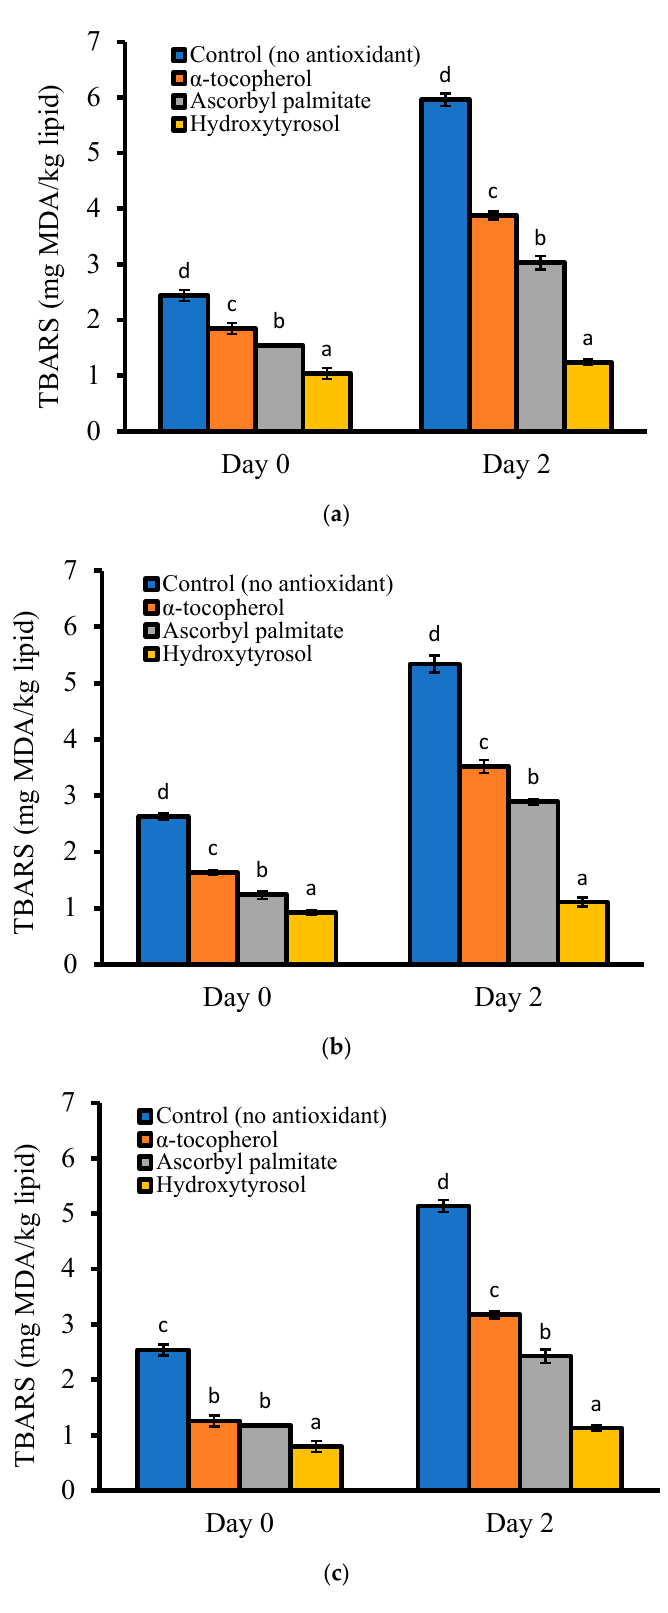
Figure 5. The thiobarbituric acid reactive substances (TBARS) values of oil extracted from ( a ) squid, ( b ) hoki and ( c ) prawn after deep frying and refrigerated storage. Values are expressed as mean ± stan- dard deviation ( n = 3). Bars not sharing a common letter are significantly different ( p < 0.05) within each